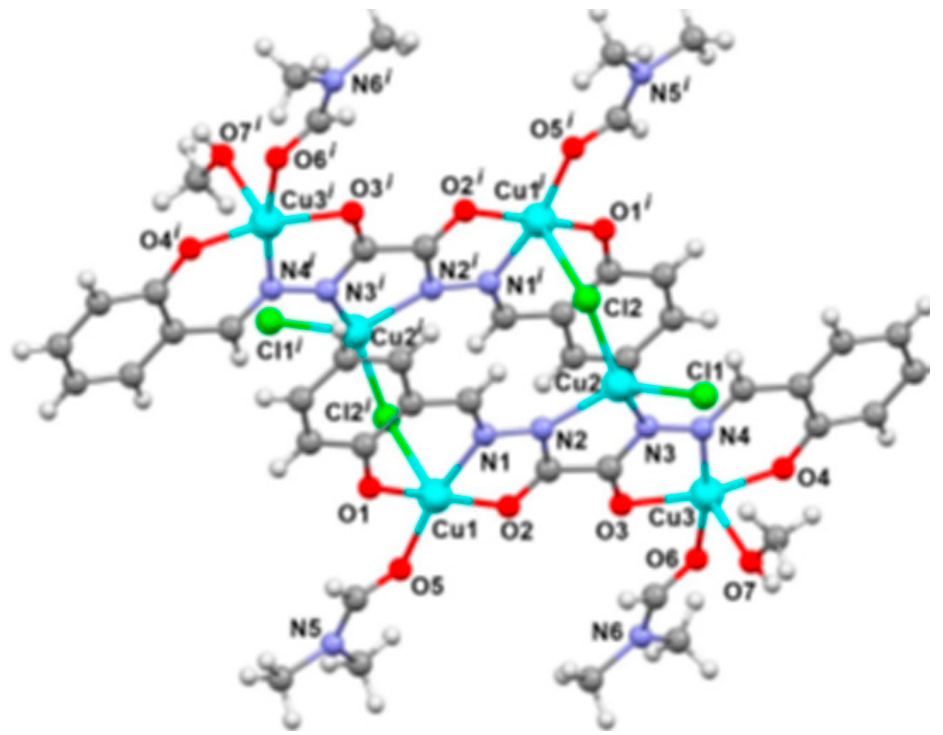
Figure 7. Complex tested in oxidations with peroxides adapted from Ref. [70], Copyright (2020), Int. J. Mol. Sci. (MDPI), Open Access.